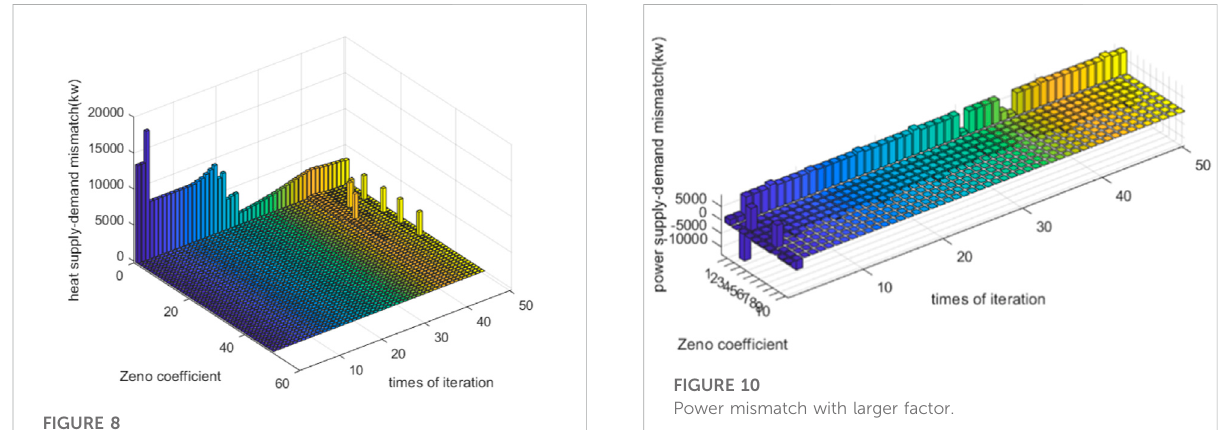
FIGURE 8 Convergence procedure of heat supply-demand mismatch.